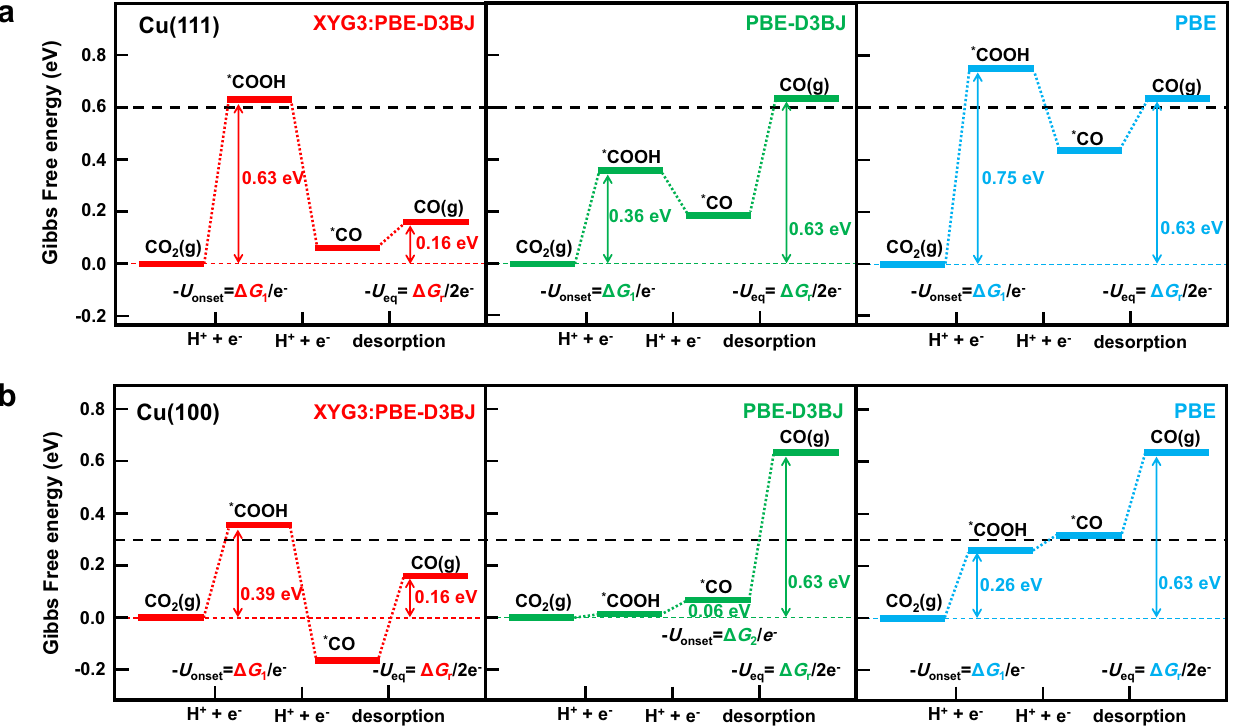
Fig. 4 | Applications in electrocatalytic CO 2 reduction to CO on the copper surfaces. Free energy diagrams for CO 2 RR to CO on a Cu(111) and b Cu(100) electrodes. The corresponding free energy diagrams predicted by XYG3:PBE-D3BJ (red), PBE-D3BJ (green) and PBE (blue) are compared in the context of the com- putational hydrogen electrode (CHE) method. The black dashed lines at a 0.60eV